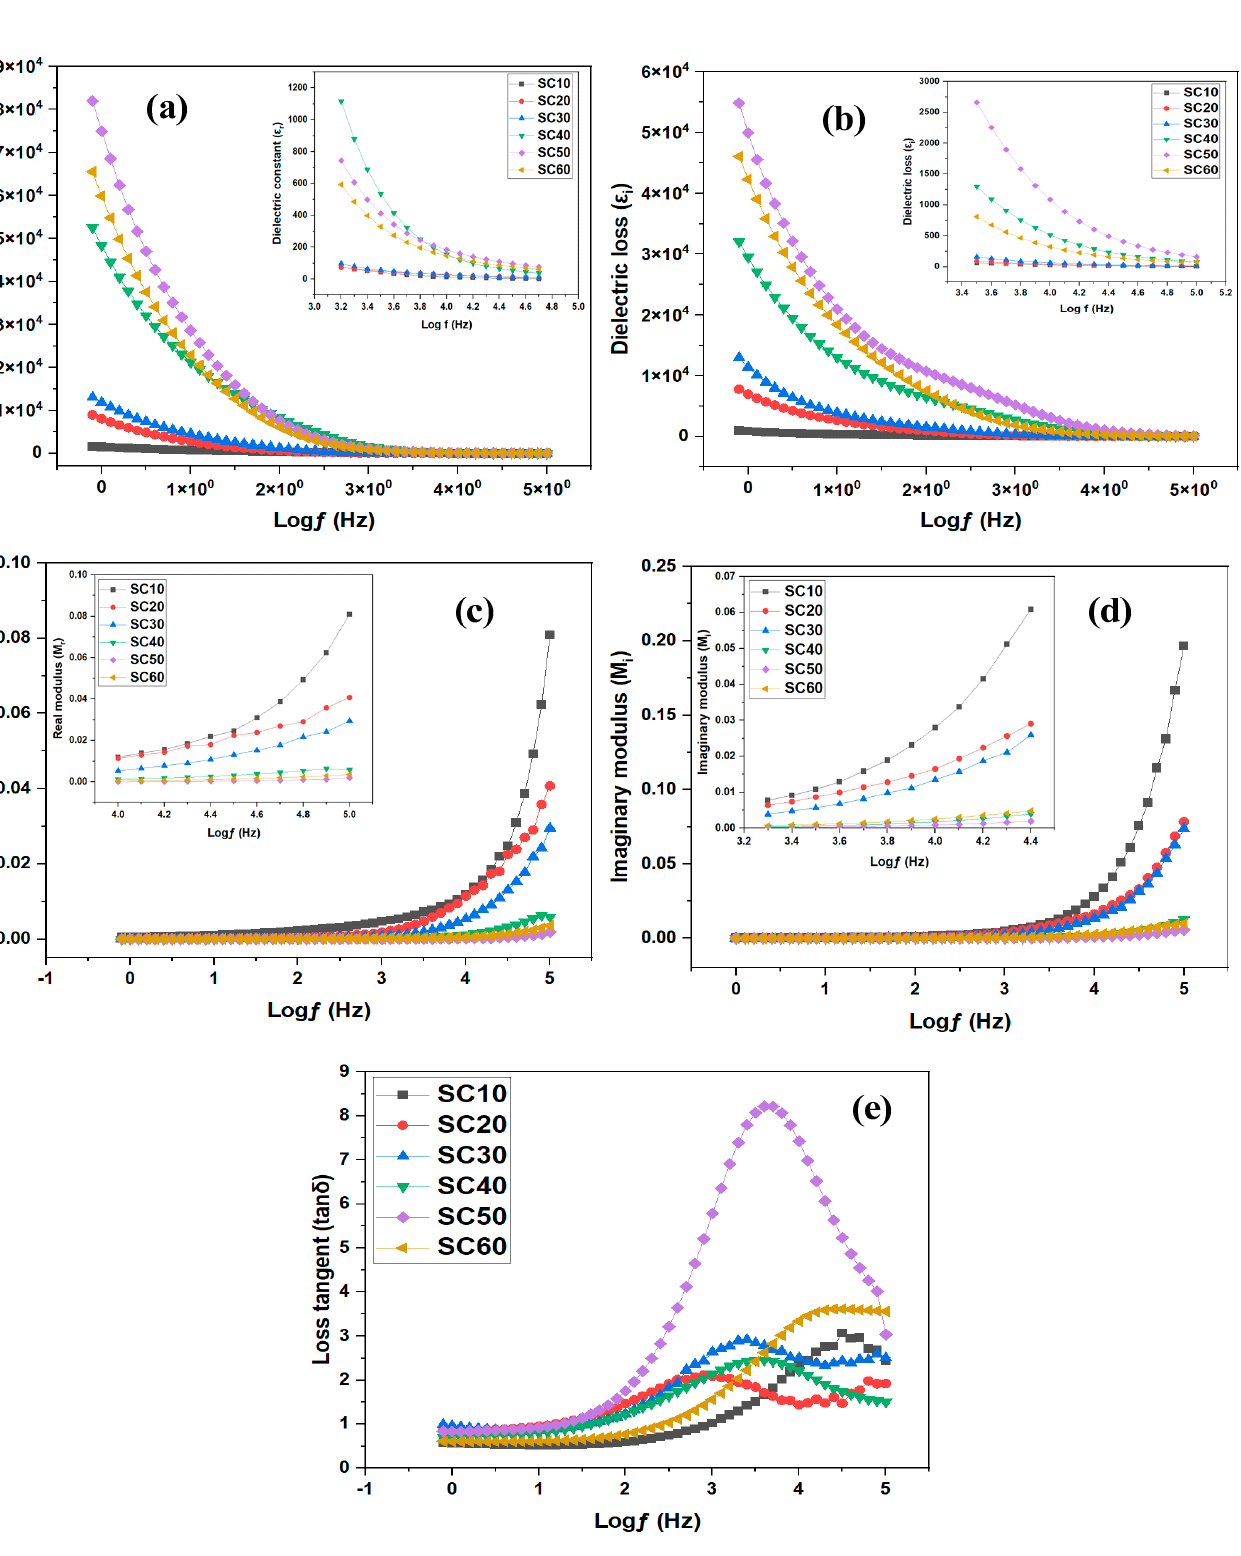
Figure 5. Dielectric and energy modulus of SBE: ( a ) dielectric constant, ( b ) dielectric loss, ( c ) real modulus, ( d ) imaginary modulus, and ( e ) loss tangent.